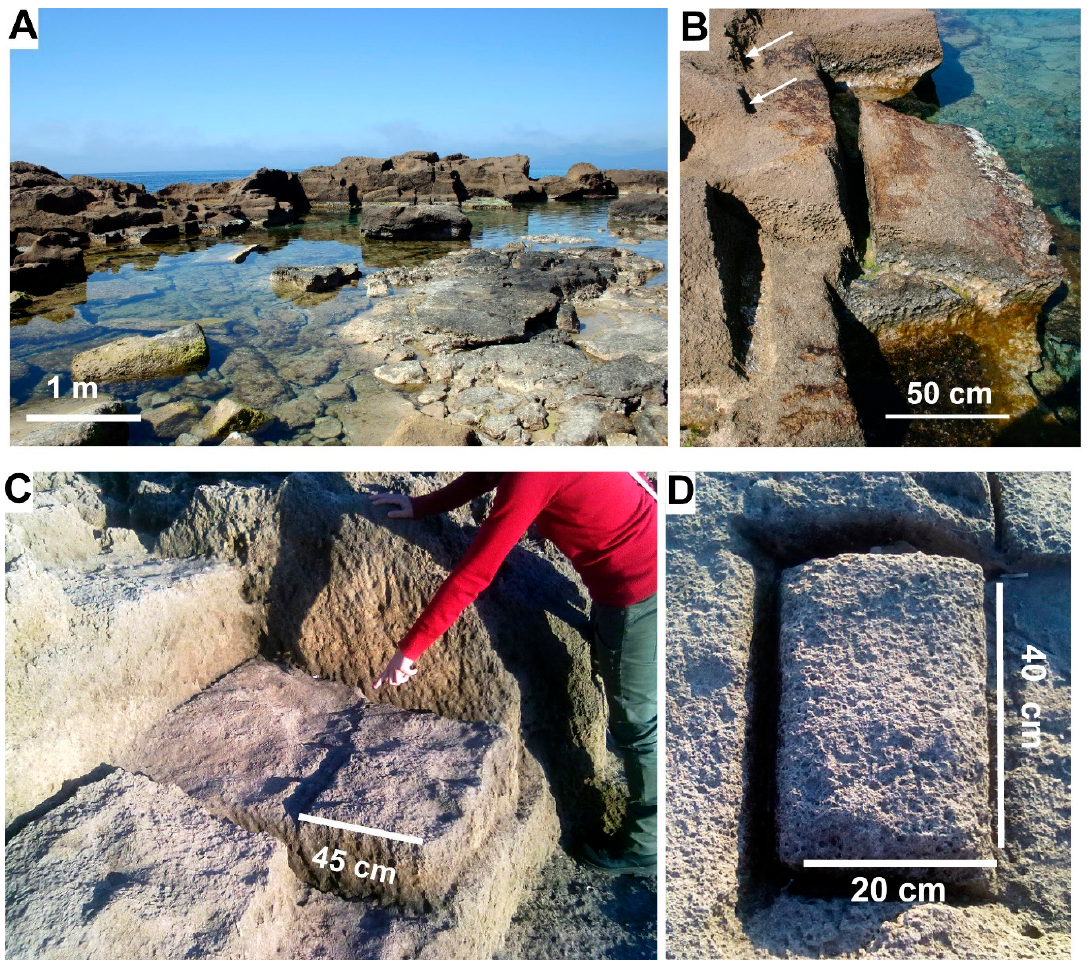
Figure 12. Zio Peppino quarry. ( A ) Underwater quarry plane. Note that blocks were carved from the top to the bottom according to the depth of a standard block. ( B ) Sing of the iron (or wood) wedges introduced to crack the sandstone blocks. ( C ) Perpendicular grooves made on sandstones with the help of a pickaxe (picaza). ( D ) Detail view of a squared